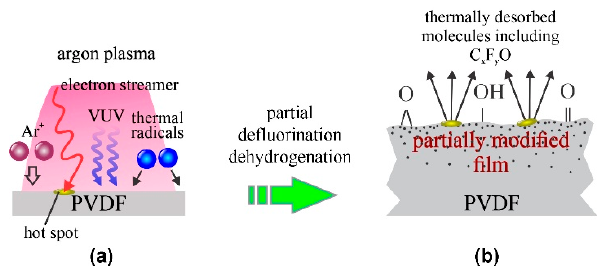
Figure 3. Mechanisms involved in surface modification of PVDF upon exposure to atmospheric- pressure argon jet: ( a ) polymer is exposed to slow ions, weak VUV radiation and radicals or residual atmosphere, temporally and spatially limited hot spots appear at the surface where electron streamers impinge, and ( b ) formation of a gradient surface film, radical-dependent surface oxidation and etching at hot spots.